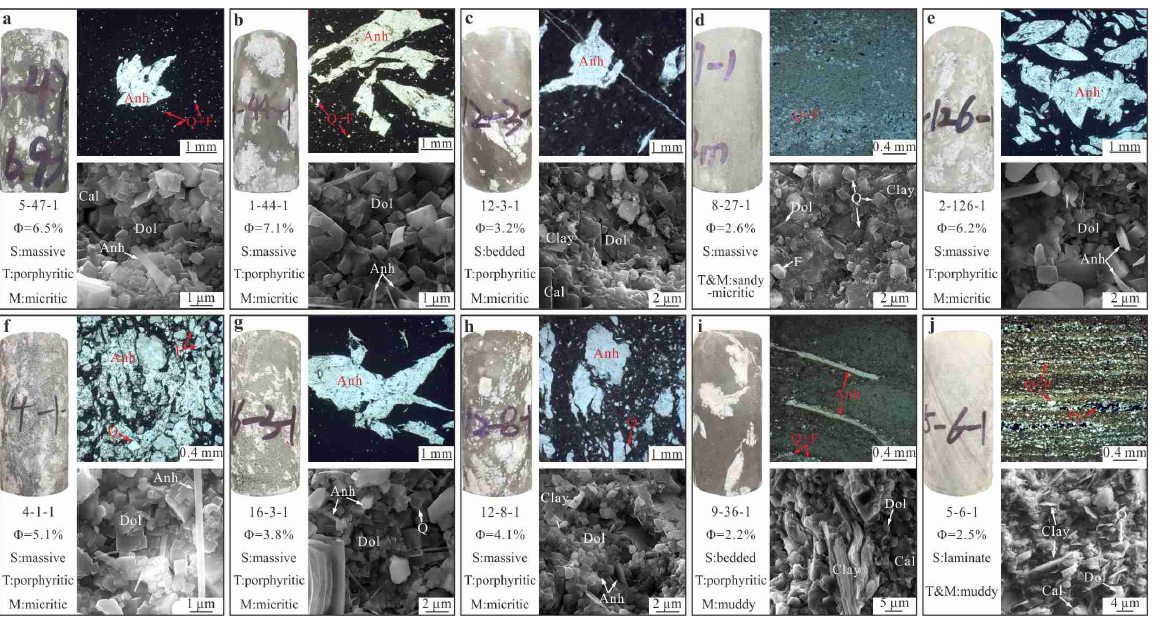
Figure 4. Petrographic charateristics of tested samples ( Φ —porosity, S—structure, T—Texture, M— texture of matrix). ( a ) 5-47-1, anhydrite dolomite; ( b ) 1-44-1, anhydrite dolomite; ( c ) 12-3-1, dolomite; ( d ) 8-27-1, argillaceous dolomite; ( e ) 2-16-1, anhydrite dolomite; ( f ) 4-1-1, anhydrite dolomite; ( g ) 16- 3-1, anhydrite dolomite; ( h ) 12-8-1, anhydrite argillaceous dolomite; ( i ) 9-36-1, argillaceous dolo- mite.; ( j ) 5-6-1, argillaceous